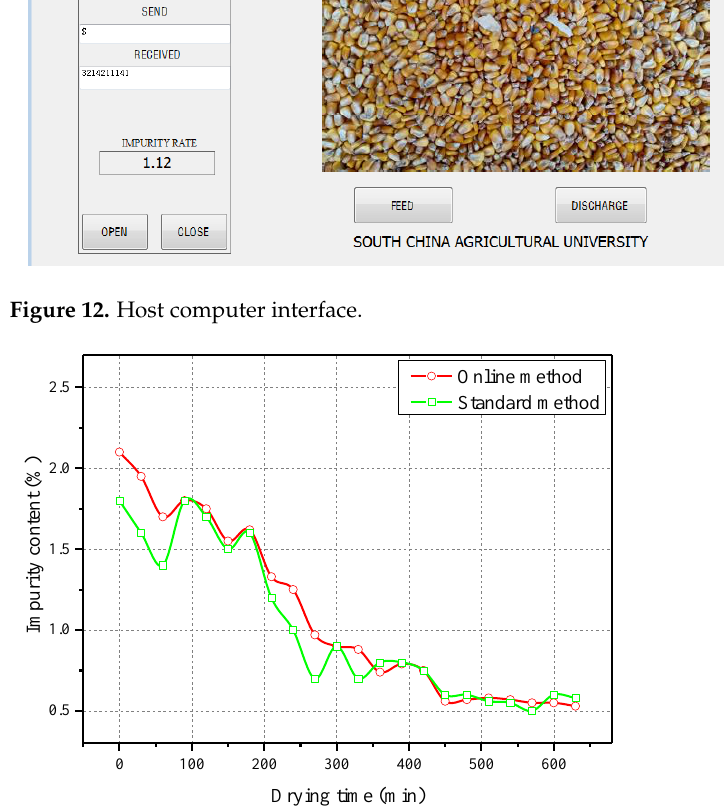
Figure 13. Impurity content measured by standard method and online method in the corn drying process.